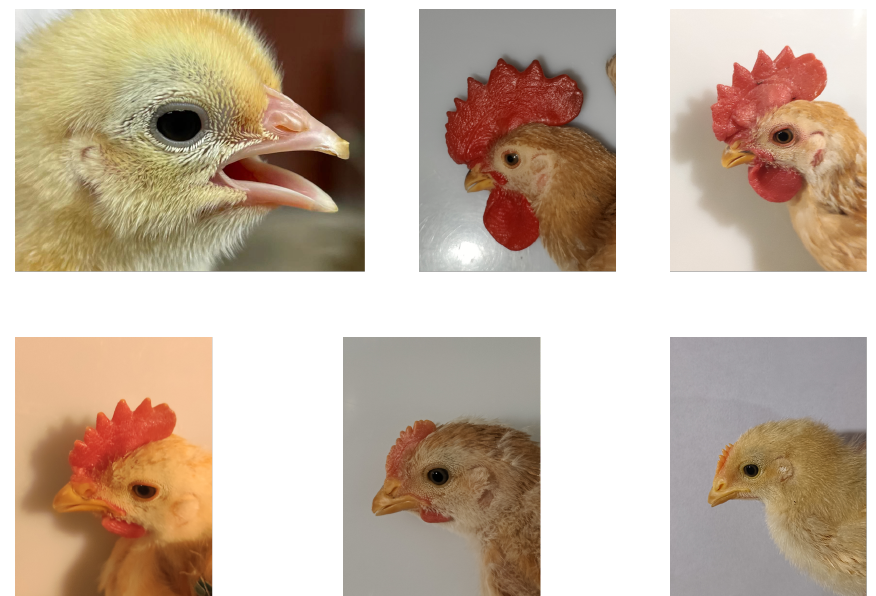
Figure 3. Exhibition of the chicken dataset from different